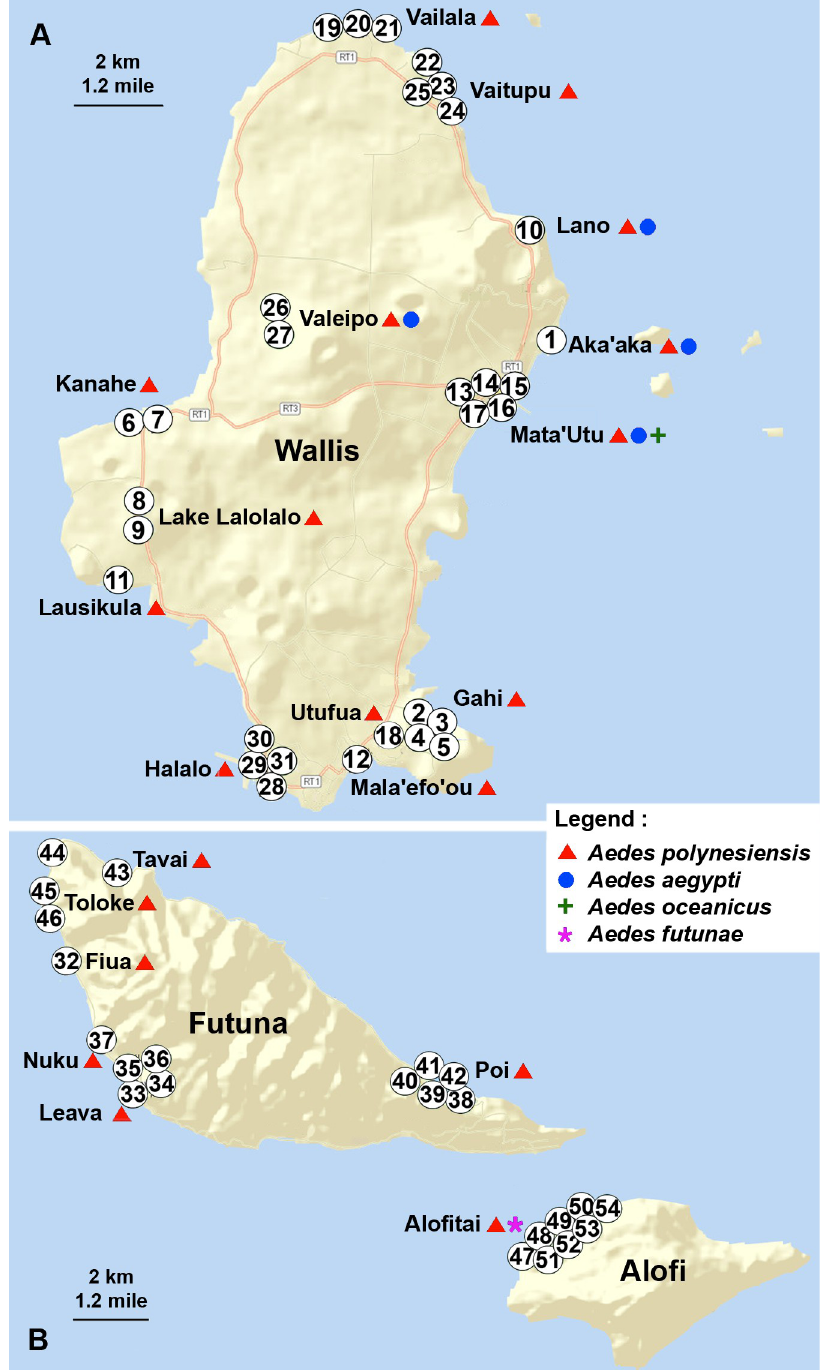
Fig 2. Geographical location of the mosquito sampling sites and distribution of Aedes spp on Wallis and Futuna. The numbers represent the 54 sampling points on (A) the island of Wallis, (B) the islands of Futuna and Alofi. The presence of the different Aedes species is represented by a sign near the locality name according to the legend on the map. Open source maps from USGS LandsatLook (https://landsatlook.usgs.gov/viewer.html) annotated with Adobe Photoshop